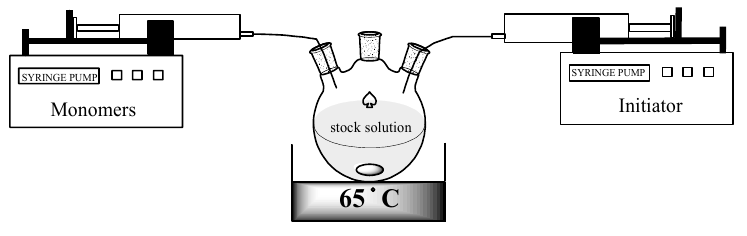
Figure 5. Typical set-up for the continuous addition experiment.